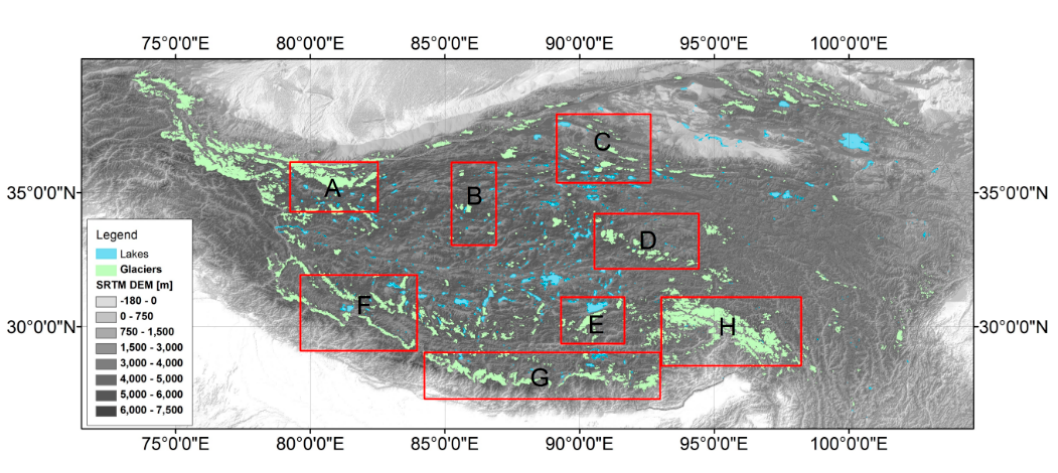
Figure 10. Sub-regions applied for monitoring glacial thickness change at the Tibetan Plateau. Table 5. Mean glacial thickness change rates per sub-region, where N is the number of observed glaciated areas within each sub-region, compared to the results of Neckle et al. (2014) [16]. Sub-Region